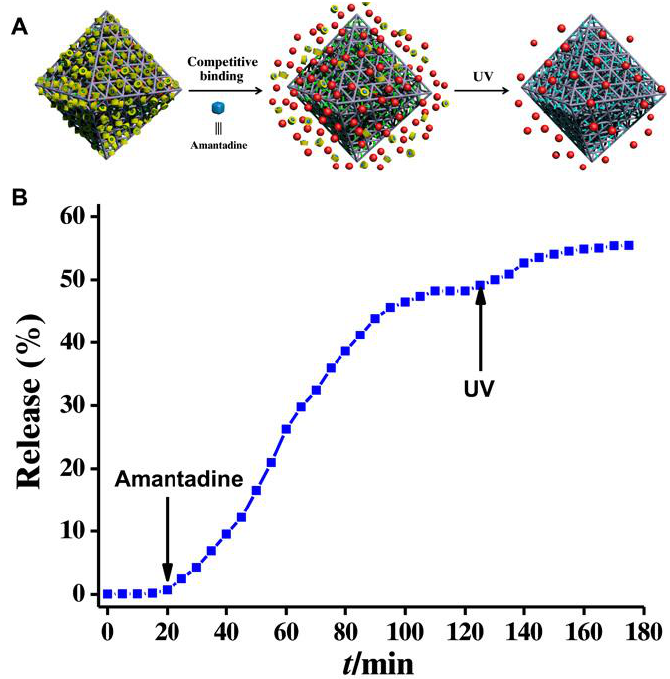
Figure 6. ( a ) Schematic illustration of the controlled release system upon the addition of a competitive guest, amantadine, as well as exposure under UV irradiation. The trans -azobenzene and its cis -isomer are colored in green and cyan, respectively. ( b ) Changing points in the release profile of CDs capped UiO-68-azo-bearing Zr-MOFs. Reproduced from Reference [17] with permission from the American Association for the Advancement of Science, copyright 2016.